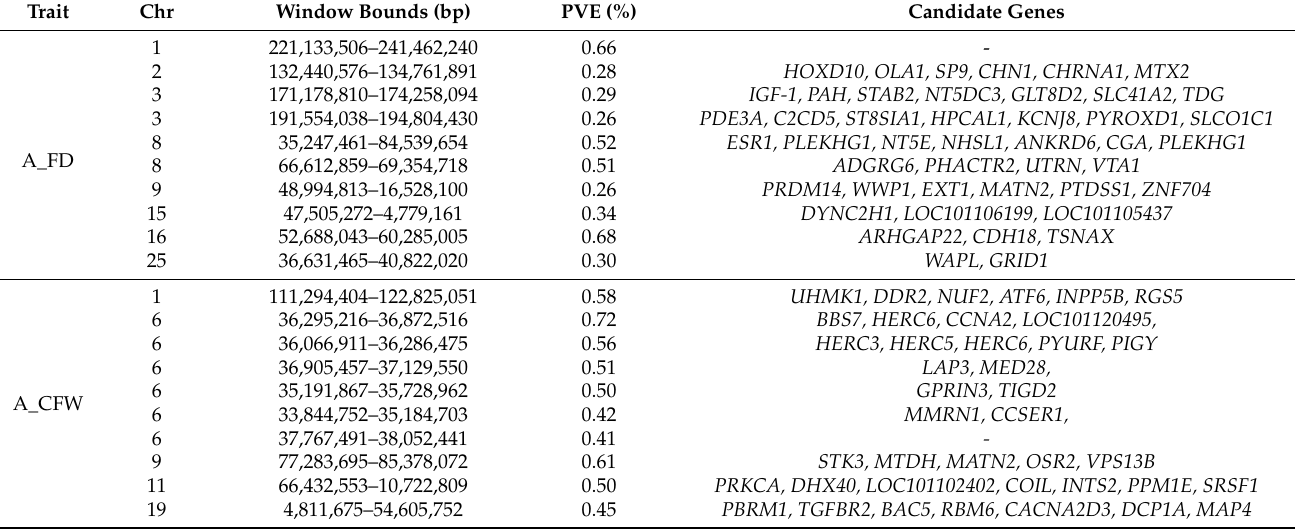
Table 2. Chromosome, location, proportion of additive genetic variance (PVE, %) and candidate genes within the top 10 windows associated with the fiber diameter (A_FD) and clean fleece weight (A_CFW) of Merino ewes.